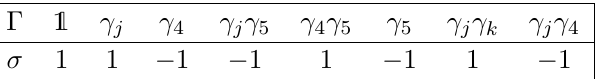
Table 1 . Sign factors (cid:27) for the di(cid:11)erent Dirac matrices (cid:0). Here j; k